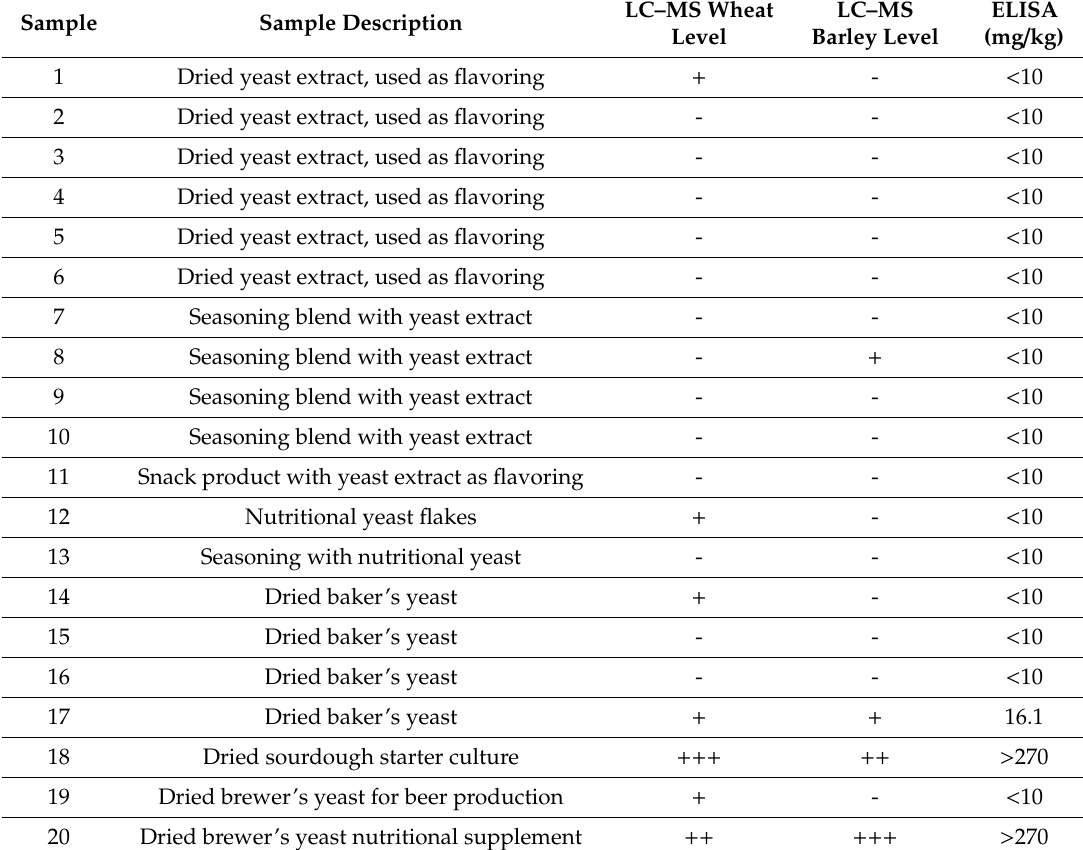
Table 1. Sample identities and relative wheat and barley gluten